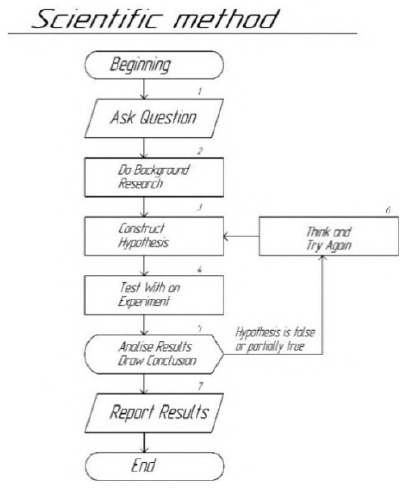
Figure 1: Stages of the scientific research